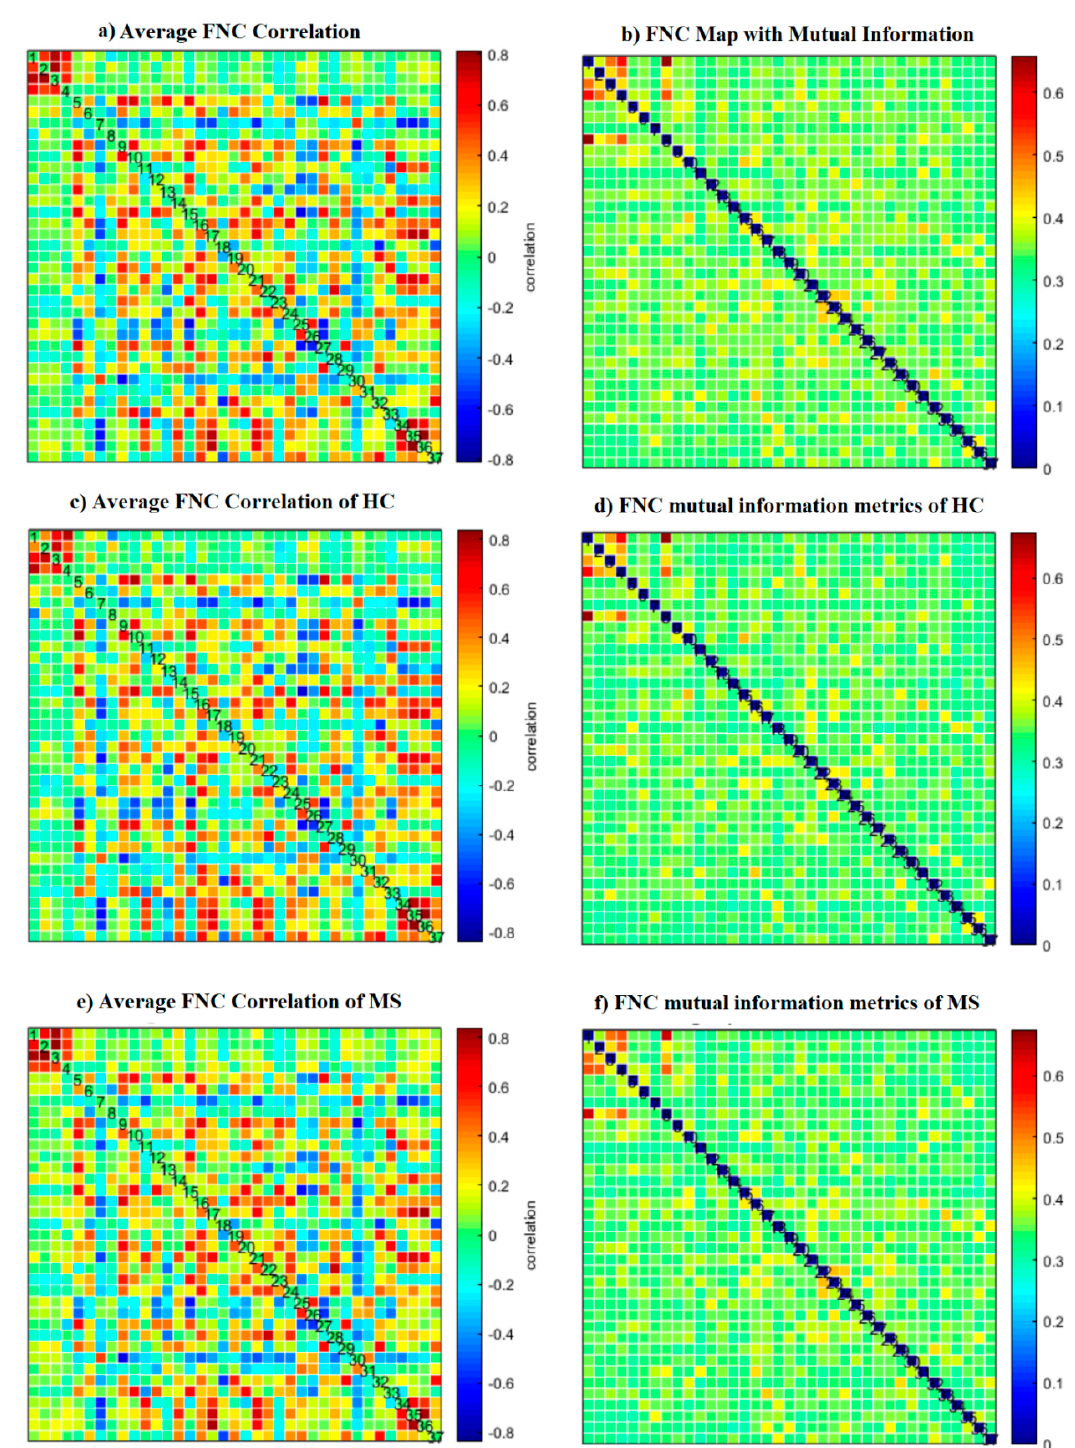
Figure 3. ( a ) Static functional network connectivity correlations were computed for each averaged across sessions. ( b ) FNC metrics of component spatial maps. Mutual information was computed between components and averaged across datasets. ( c ) Functional network connectivity correlations were computed for average HC dataset. ( d ) Mutual information was computed between components spatially for the HC dataset. ( e ) Functional network connectivity correlations we computed for the average MS dataset. ( f ) Mutual information was computed between components spatially for the MS dataset .